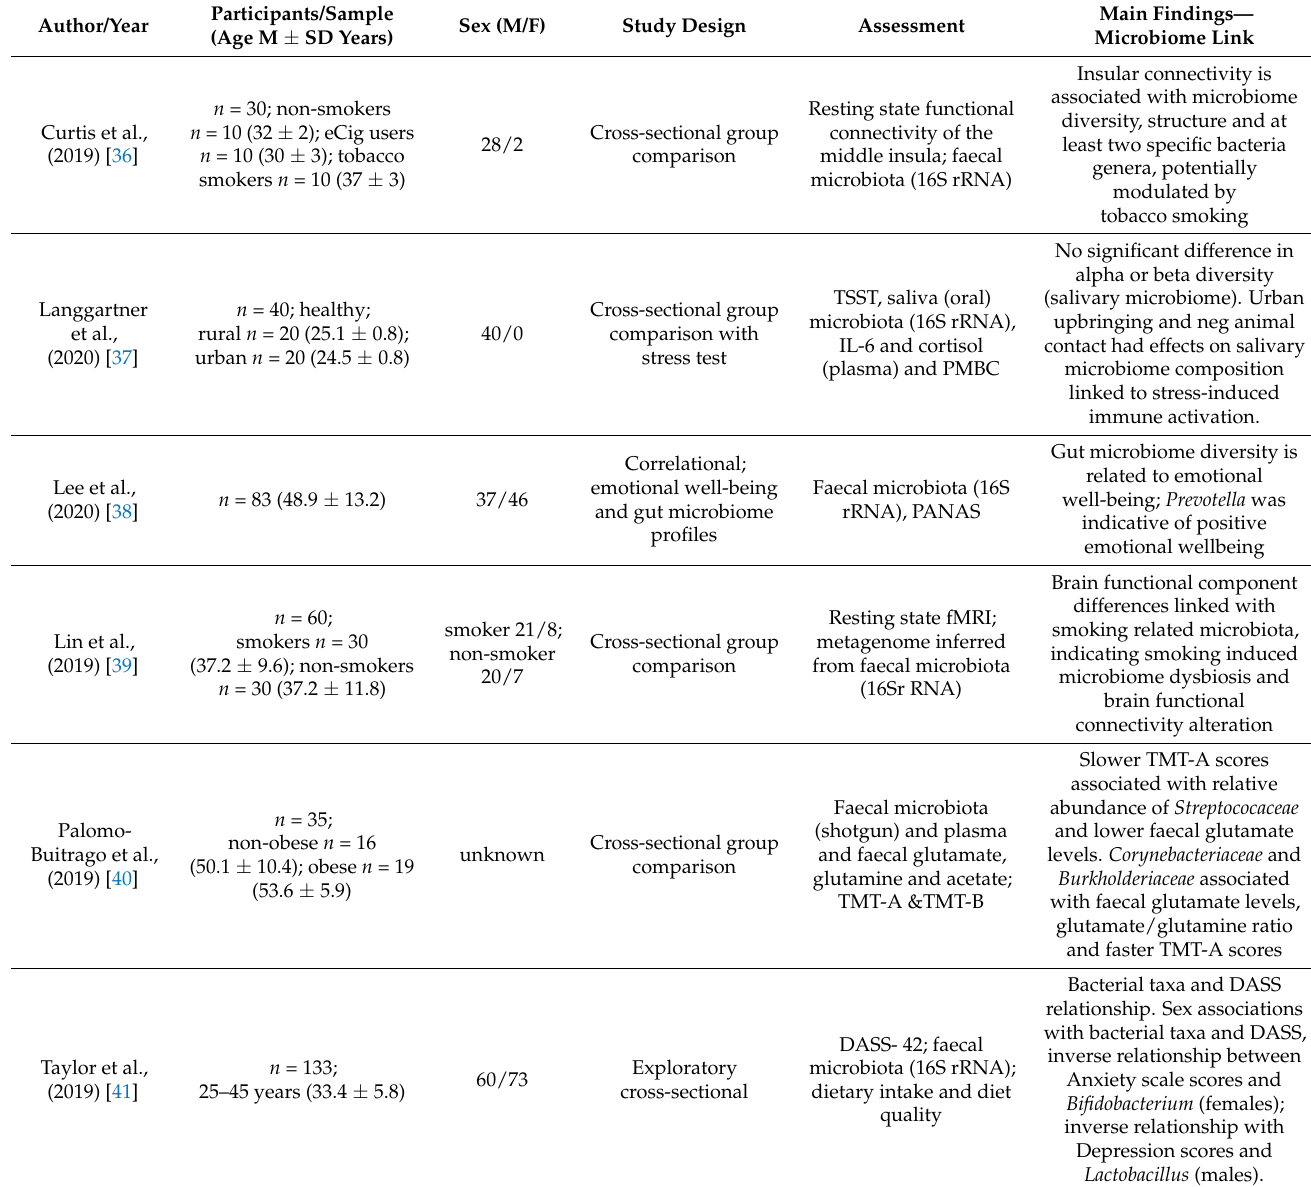
Table 2. Exploratory human studies describing correlations/interactions between microbiota and cognition, brain structures, function and stress (no